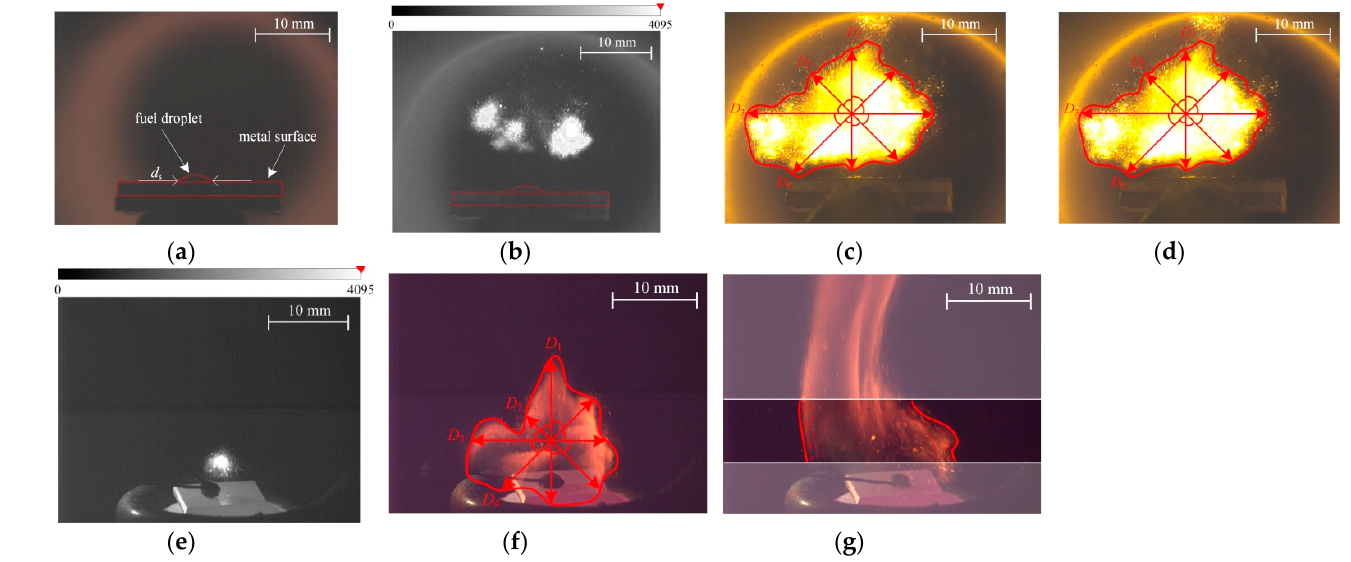
Figure 5. Typical frames of video recording processing to determine the ignition and combustion characteristics of fuel droplets. Characteristics determined for a mixed heat supply were d s ( a ), τ d ( b ), D max ( c ), and N ( d ). Characteristics determined for a conductive heat supply were τ d ( e ), D max ( f ), and N ( g ).